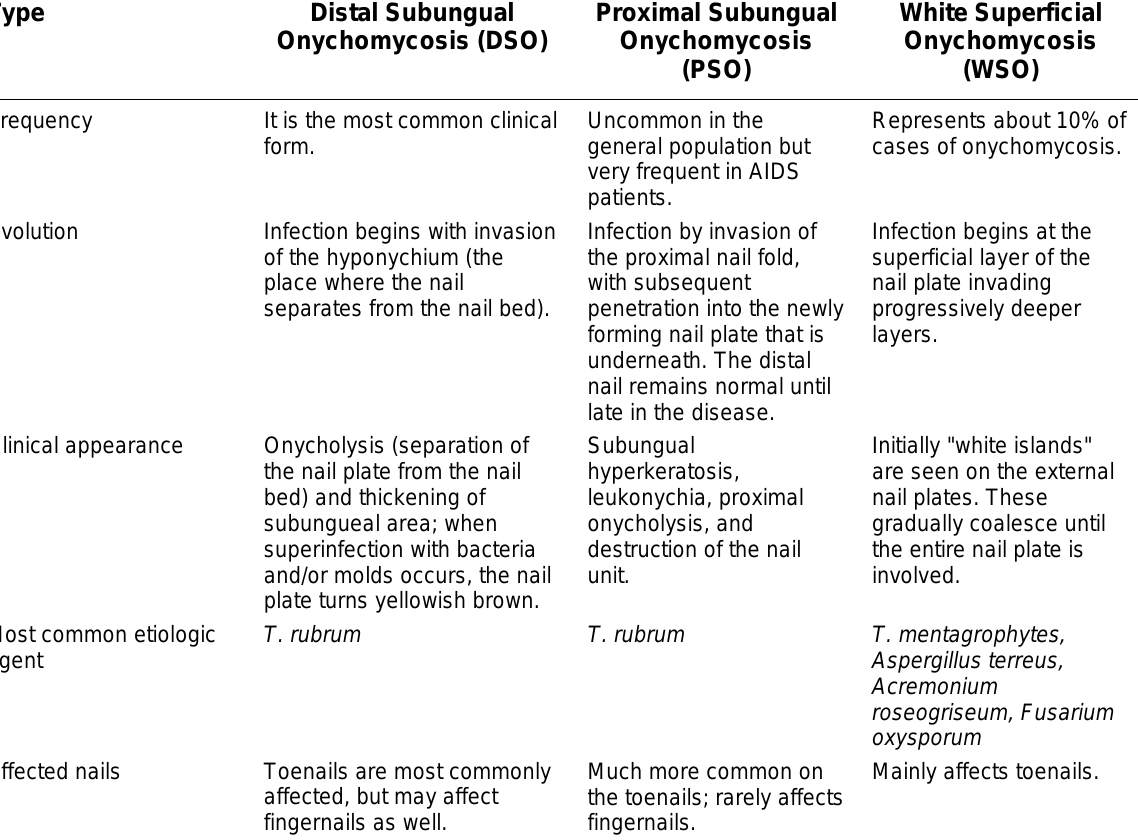
Summary of the Reported Characteristics of Onychomycosis